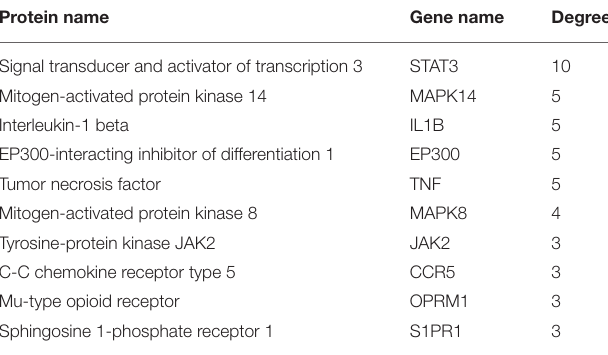
TABLE 2 | Candidate targets of SBP on CAD screened by Cytoscape and their